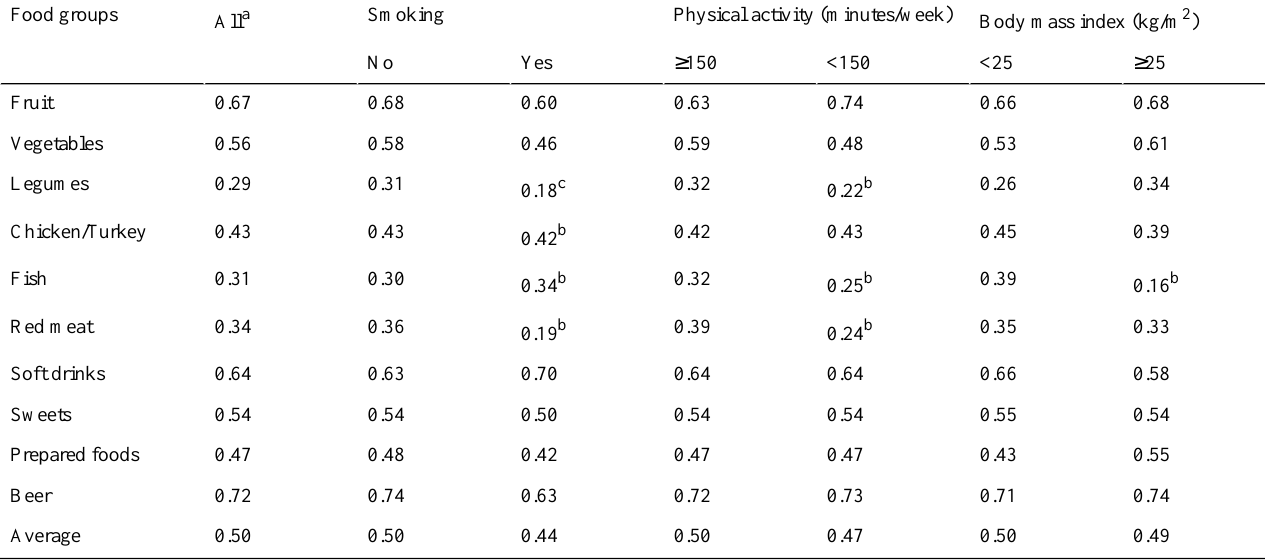
Table 13. Weighted kappa derived from the electronic 12-hour dietary recall app versus the 4 dietary records for categories of food group consumption and strata: smoking: no and yes; physical activity (minutes/week): ≥ 150 and <150; and body mass index (kg/m 2 ): <25 and ≥ 25. Comparison of the electronic 12-hour dietary recall app versus dietary records.